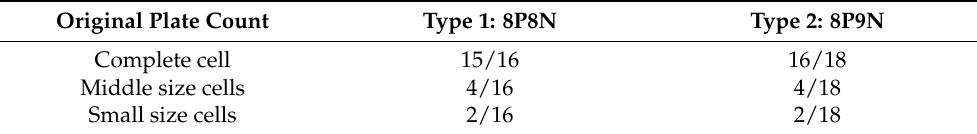
Table 3. Scaling factors according to the number of active plates within a cell (Reprinted from Ref.